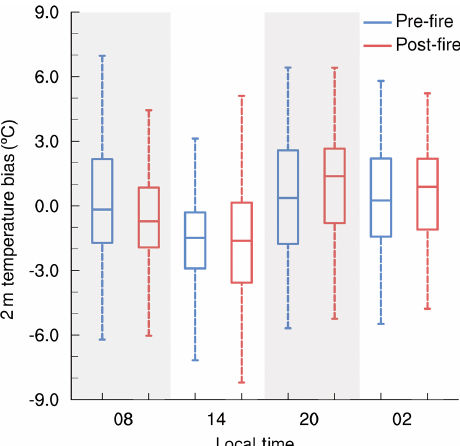
Figure 6. Temperature bias at 2m height, defined as the value of OBS minus FNL, at stations over fire-prone areas at 08:00, 14:00, 20:00, and 02:00LT under clear-sky conditions pre/post-fire in